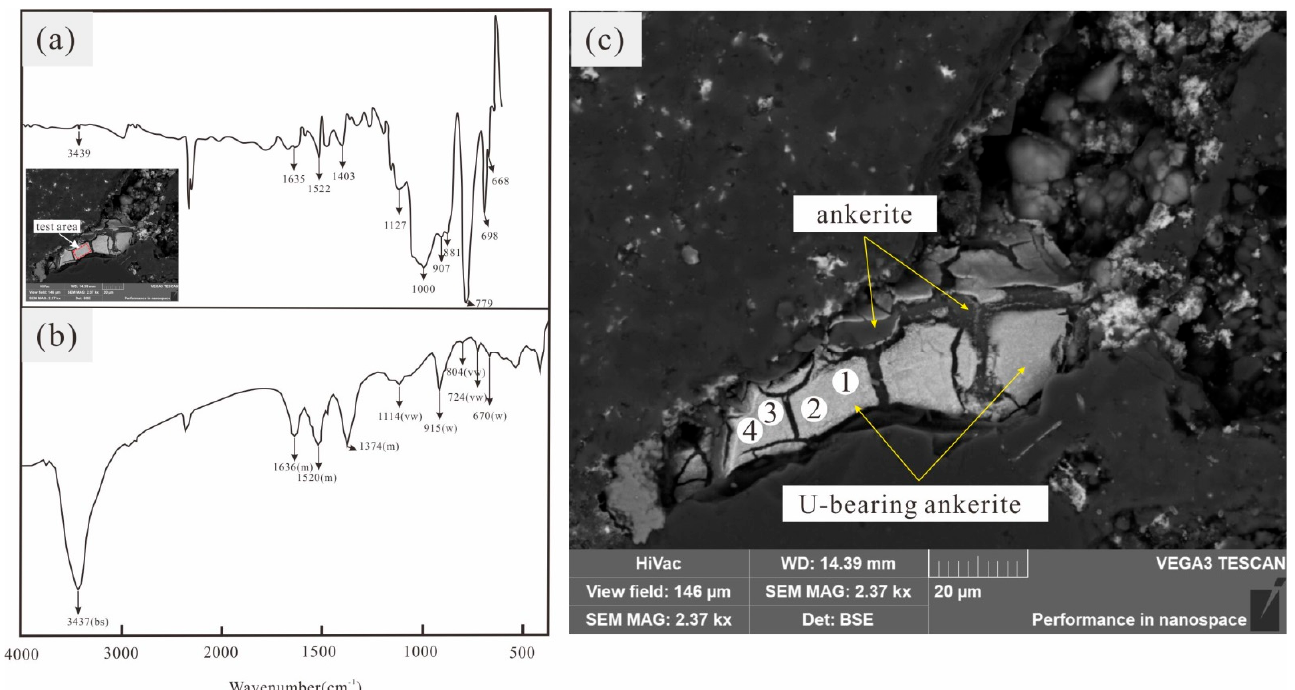
Figure 5. Analyses result of an infrared-absorption spectrum of U-bearing carbonate minerals ( a ) and Oswaldpeetersite ( b ) and EPMA ( c ) of U-bearing carbonate minerals. Table 1. Analyses result of an infrared-absorption spectrum of U-bearing carbonate minerals.